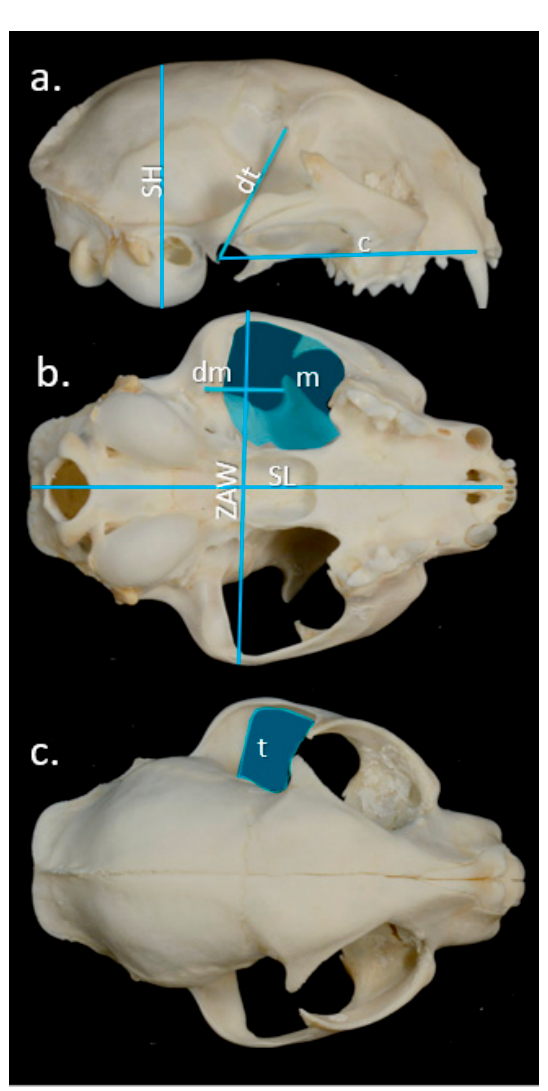
Figure 1. (a) Right lateral, (b) ventral and (c) dorsal view of a cat ( Felis catus ) skull. Distances recorded for estimation of bite force: (a) SH skull height, dt the distance between the centroid of the temporalis and Temporo-Mandibular Joint (TMJ) and c distance between the canine and TMJ; (b) ZAW zygomatic arch width, SL ventral skull length, dm distance between the centroid of the masseter muscle and the TMJ, and the cross-sectional areas of the masseter muscle/pterygoideus muscle ( m ); and, (c) the cross-sectional area of the temporalis muscle ( t ).